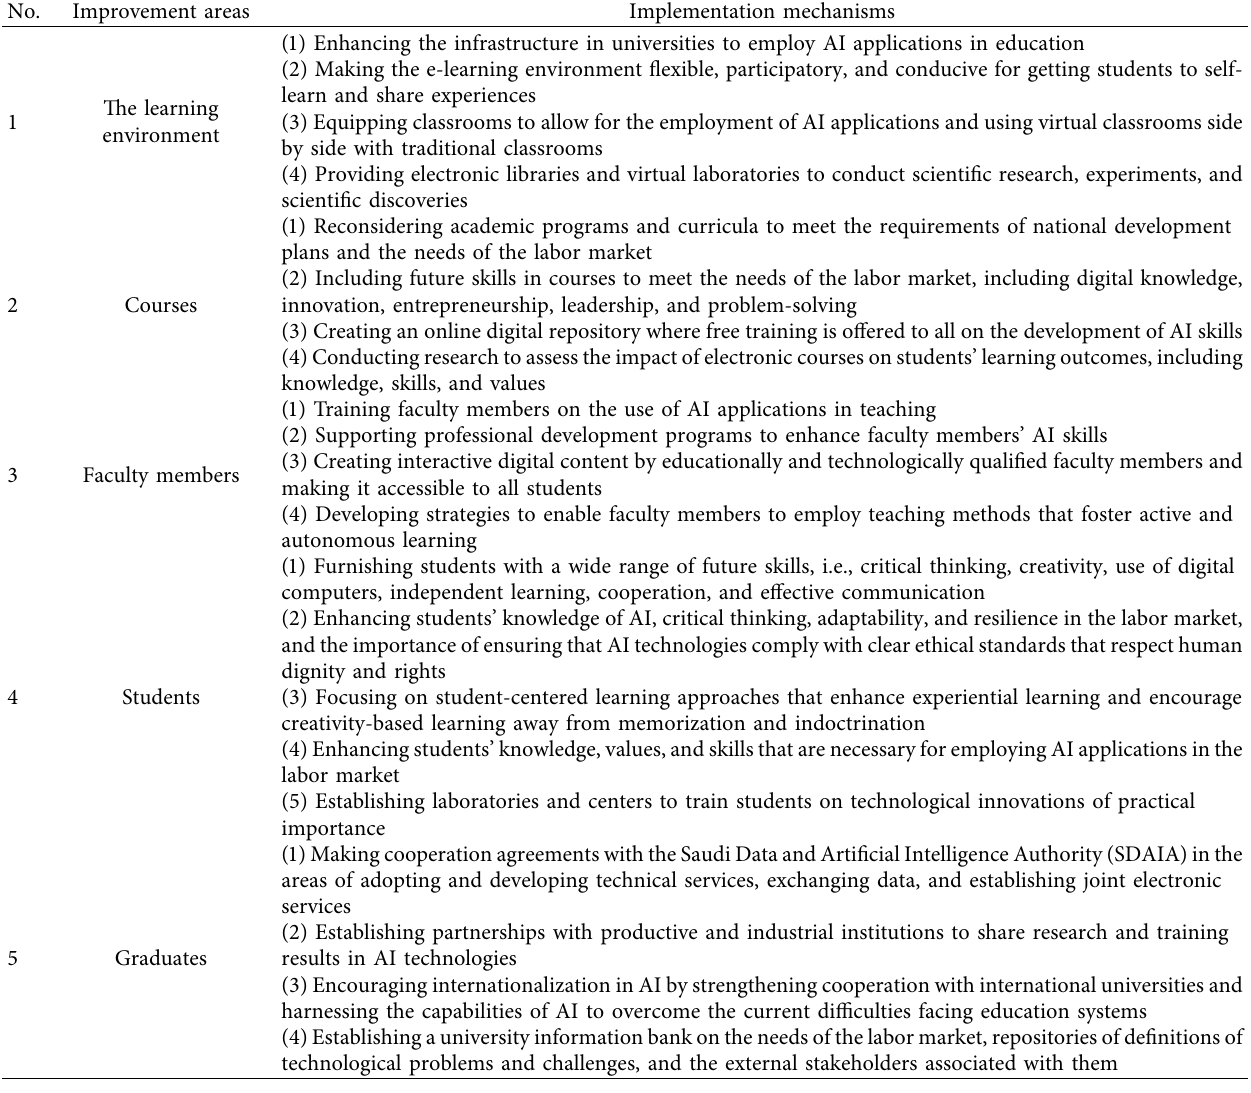
Table 13: The suggested proposal for meeting the requirements to employ AI applications in developing students’ future skills. No.